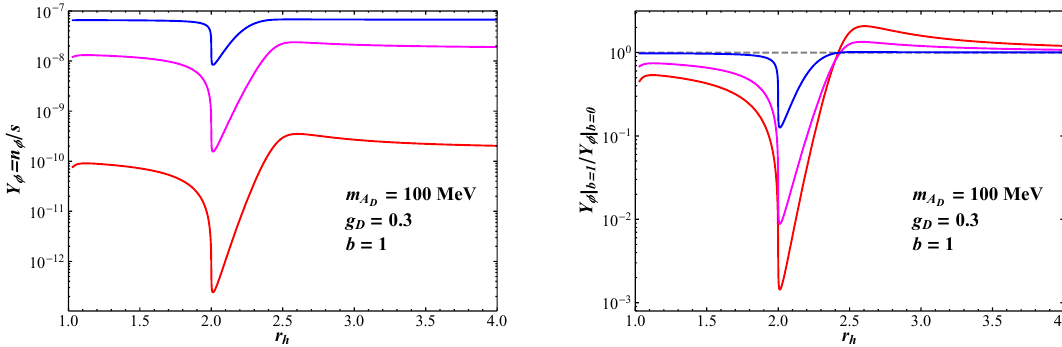
Figure 6. (Left) The DM yield as a function of r h = m h D /m A D , assuming a dark photon mass m A = 100 MeV, a dark gauge coupling of g D = 0 . 3 , and a dark Higgs-DM coupling parameter D b = 1 , as discussed in the text. Selections of r φ = m A /m φ are r φ = 1 . 2 (Red), r φ = 1 . 4 (Magenta), D and r φ = 1 . 6 (Blue). (Right) The same as the left, but now each yield is scaled by the value for equivalent parameter choices without dark Higgs contributions being included (that is, with b = 0